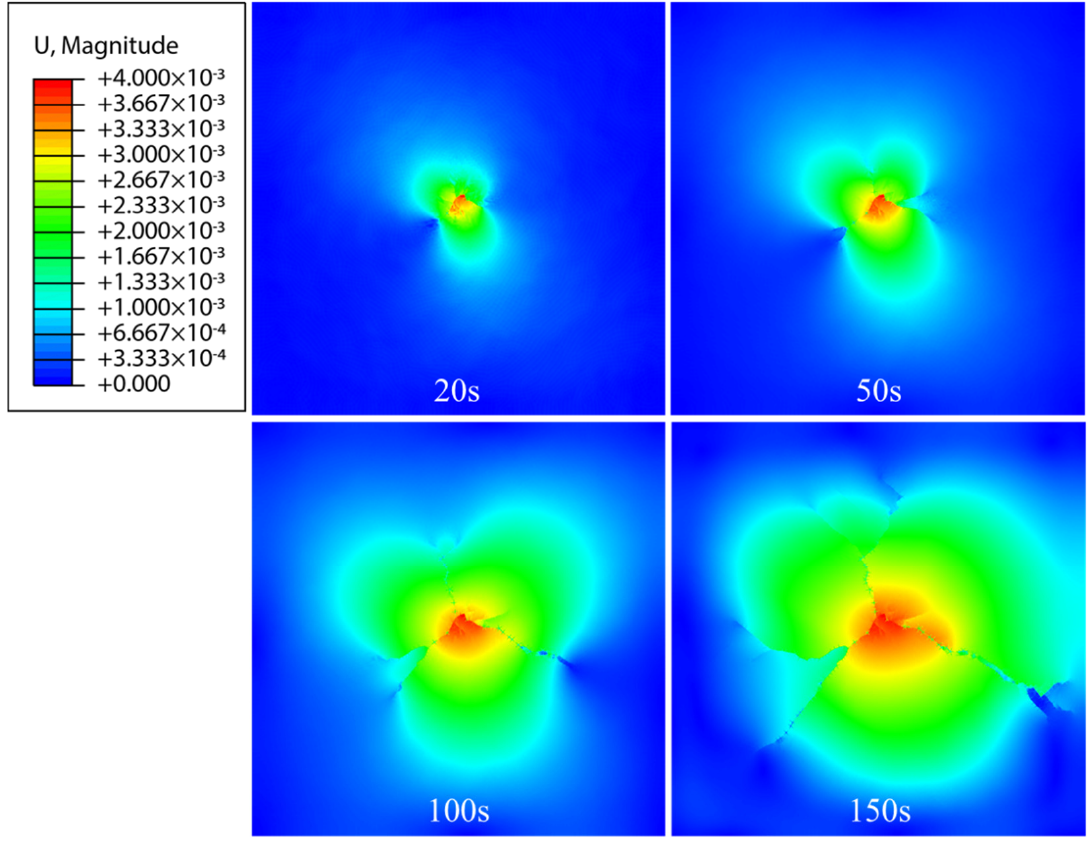
Figure 6. Pore pressure of the injection point in the natural fracture network of group B.